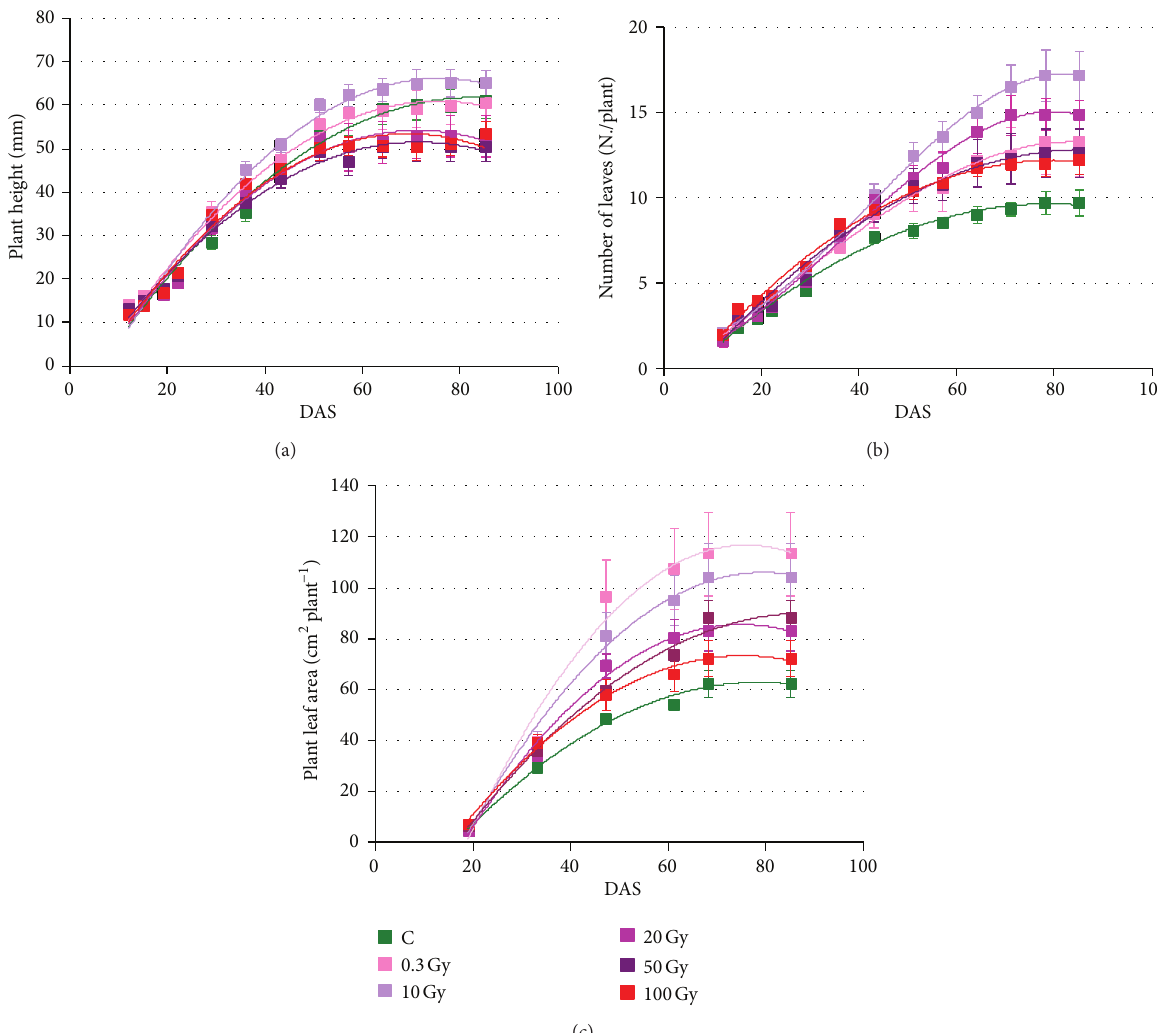
Figure 2: Time course of the plant height (a), number of leaves (b), and plant leaf area (c) in S. lycopersicum L. “Microtom” as a function of the X-ray doses applied at the seed stage. Mean values and standard errors are shown ( 𝑛 = 5 ). All second order polynomial curves had 𝑟 2 values above